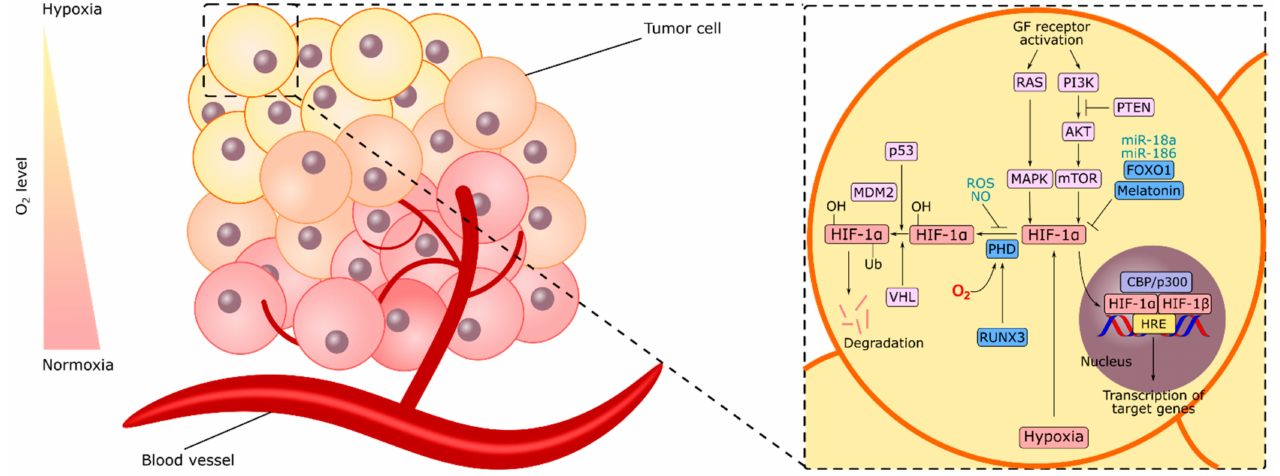
Figure 2. Regulation of HIF-1 α in hypoxic cancer cells. Common regulators in different cancers are shown in light pink. Regulators for which there is specific evidence in gastric cancer are shown in